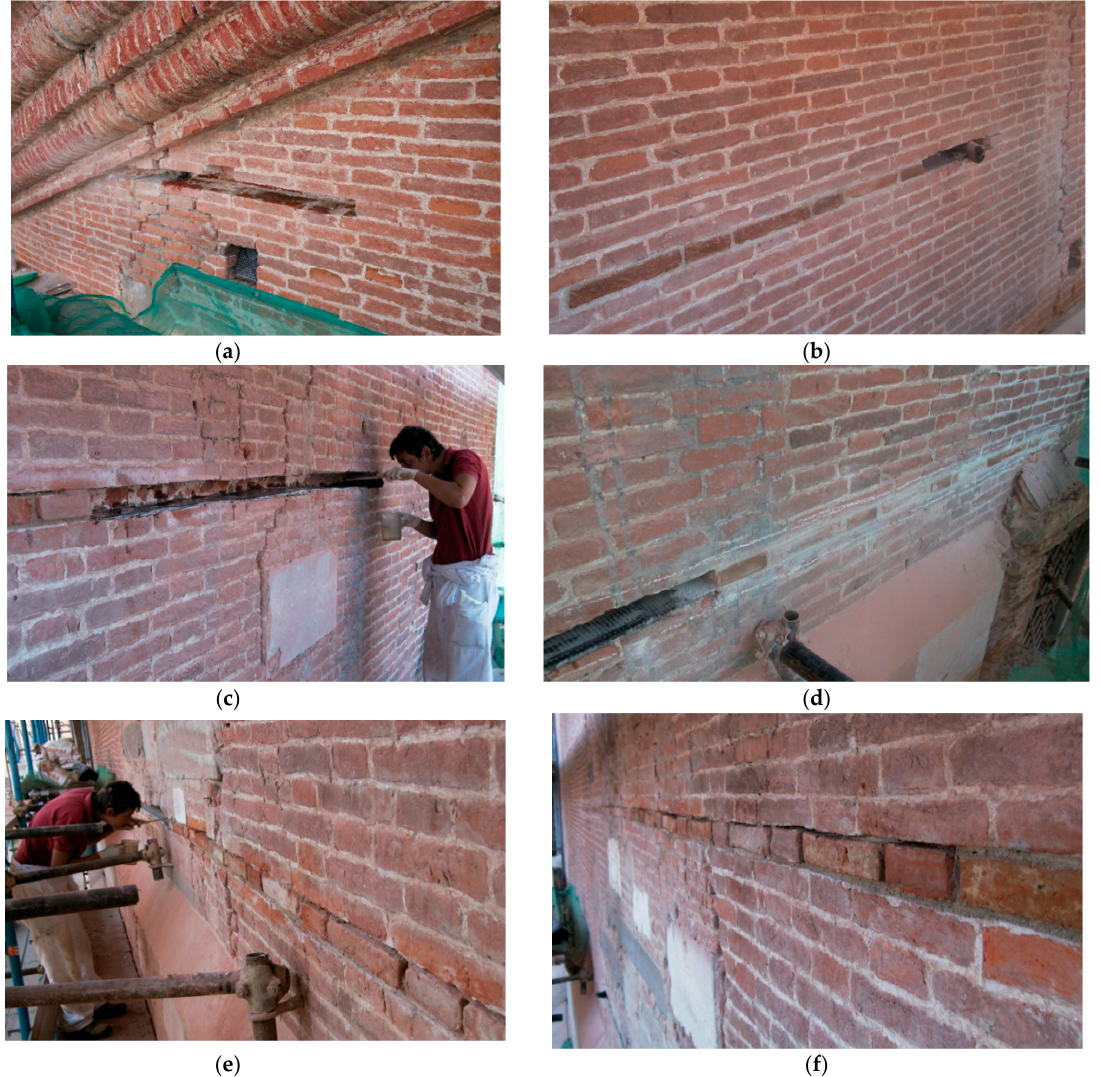
Figure 23. Relevant operational phases of the intervention: ( a ) removal of the first stretch of the brick course; ( b ) reconstruction of a stretch of the brick course, before unrolling the fiber roll; ( c ) unrolling and impregnation of fiber roll; ( d ) stretch of the brick course ready for reconstruction; ( e ) intervention in advanced stage; ( f ) intervention almost completed.